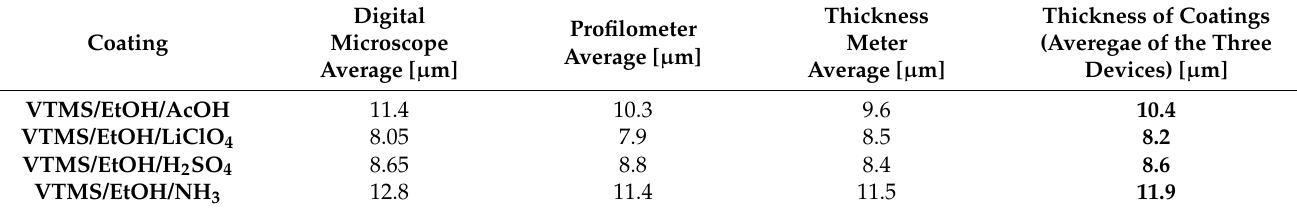
Table 7. The average thickness of the coatings calculated by measurements from three instruments (a digital microscope, profilometer, and a thickness